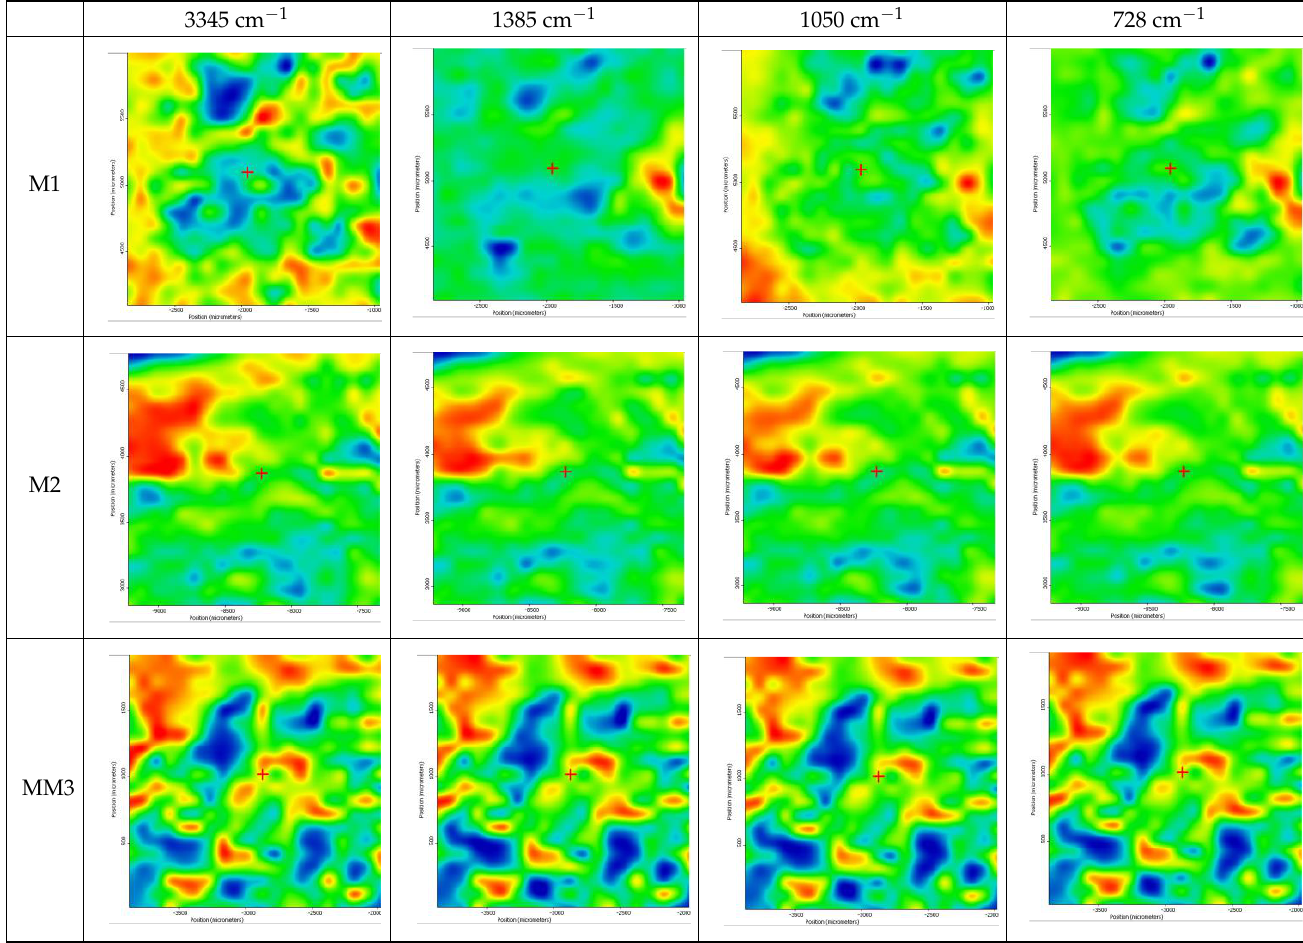
Figure 8. Video images for; ( a ) sulfonated ethylene-propylene-diene terpolymer (sEPDM) mem- brane (M1); ( b ) chitosan-sulfonated ethylene-propylene-diene terpolymer (Chi-sEPDM) membrane (M2); and ( c ) melatonin-chitosan-sulfonated ethylene-propylene-diene terpolymer (Mel-Chi- sEPDM) membrane (M3). Table 4. The FTIR 2D maps for sEPDM membrane (M1) and composite membrane (M2 and M3).